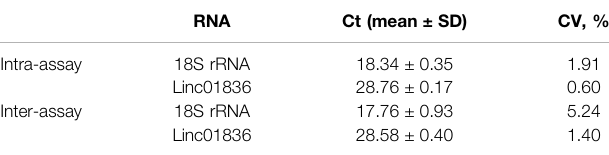
TABLE 3 | Imprecision for Linc01836 and 18S rRNA (N = 12). RNA Ct (mean ± SD) CV, %